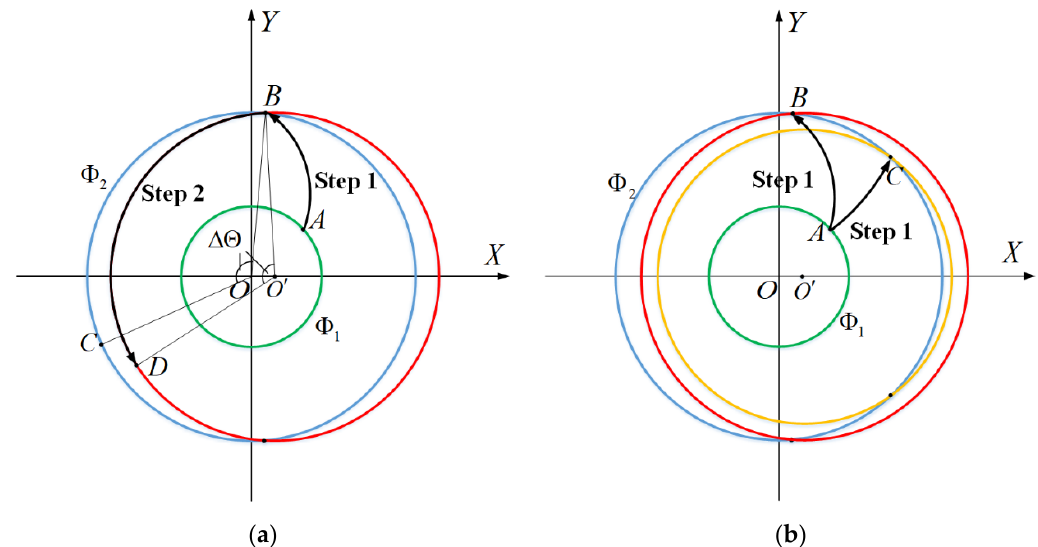
Figure 6. ( a ) Generation principle of the inverse solution error. The green circle represents the circle corresponding to the deflection angle of the initial position in the ideal pointing field, and the blue circle represents the circle corresponding to the deflection angle of the target position. The red circle represents the circle corresponding to a solution in the actual pointing field. ( b ) The principle of generating multiple solutions in inverse solution. The meanings of the green and blue circles are the same as in Figure 6a. The red and yellow circles represent the circles corresponding to the two solutions in the actual pointing field, respectively.